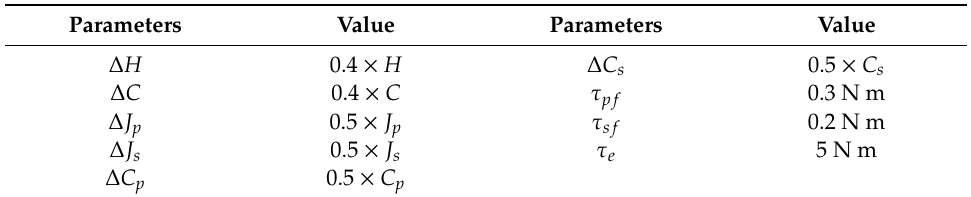
Comparing the algorithm of this paper with the FL-LESO-SMC-ISC algorithm in [37] by simulation. Table 2. VSJ system compound disturbances. The control parameter settings of the two algorithms are shown in Table